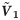
Splitting factor α = V2/(V2+V3) vs. dimensionless incoming volume V˜1 for various values of Ca and Re, in a vertical asymmetric bifurcation.The branching angles are both 45°, and the diameter ratios of daughter to parent are 0.83 and 0.72, for the large and the small daughter airways, respectively. In the left column (frames A to C), the smaller airway goes up while the larger goes down. In the right column (frames D to F), the situation is reversed. Horizontally, the values of Re and Ca in frames A and D correspond to the trachea (for a delivery at a flow rate of 6 mL.kg-1.s-1); the values of Re and Ca in frames B and E correspond to an intermediate airway (generation 6), while frames C and F correspond to a distal airway. One can observe that at small values of V˜1, tend to always favor the smaller airway independently of the orientation due to the predominance of capillary forces, while larger values of V˜1 favor the larger airway. (Reducing the flow rate for a given airway however would always favor the downwards airway, as shown in [38]).